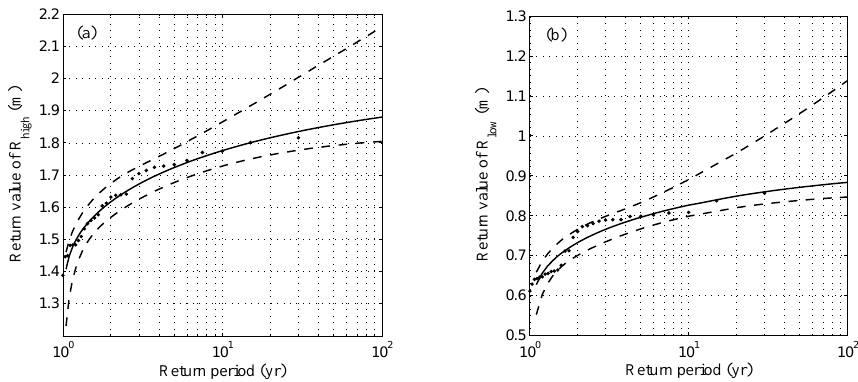
Figure 11. Return value extrapolation of (a) R high and (b) R low in the GEV model with the 95% confidence bounds.